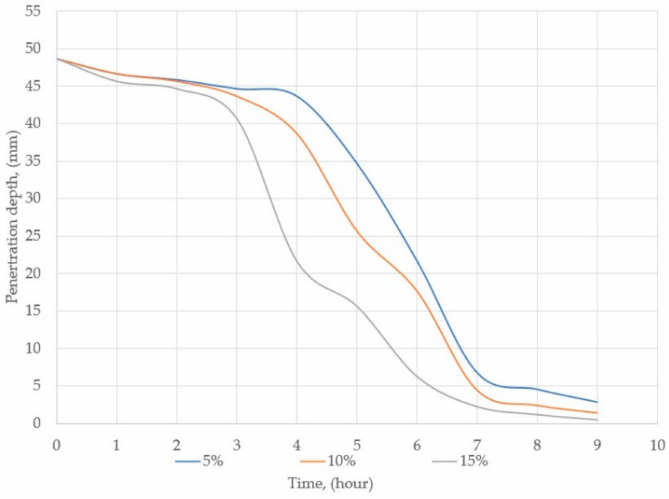
Figure 3. Determination of the curing time of the backfill mixture with the cement content: ( a ) 5%; ( b ) 10%; ( c ) 15%.